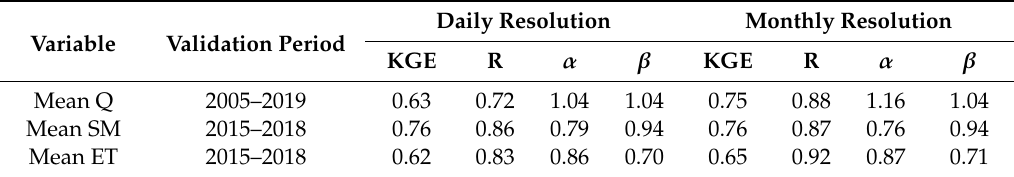
Table 3. Average skill score of all catchments (KGE: Kling Gupta e ffi ciency, R: Pearson correlation, α : standard deviation ratio, β mean ratio between BROOK90 model outputs and “observation”) for discharge (Q), SM and